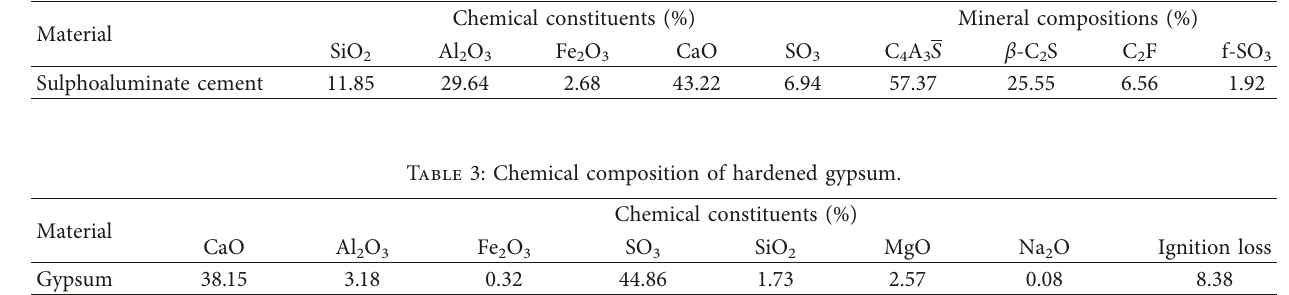
Table 2: Chemical and mineral compositions of sulphoaluminate cement.